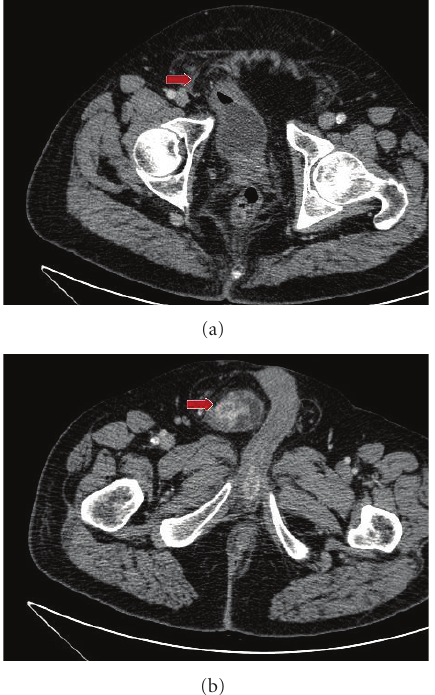
Figure 1: A right inguinoscrotal hernia with bladder contents. Note that the image suggests a bladder tumor in the 3.5cm hernia sac.